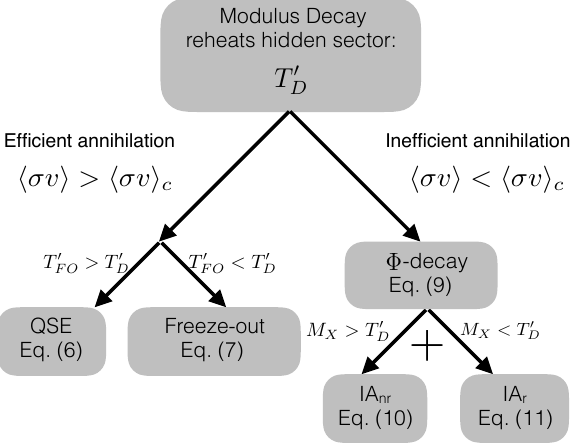
Figure 1. Flowchart showing the di(cid:11)erent categories of dark matter production mechanisms. Of note is the dependence on the modulus energy fraction going to the visible sector, and the apparent lack of strong dependence on the branching ratio B X of the modulus decay to X , due to the e(cid:14)ciency of annihilation. 3 This is the generalised version of the non-thermal WIMP miracle [9,